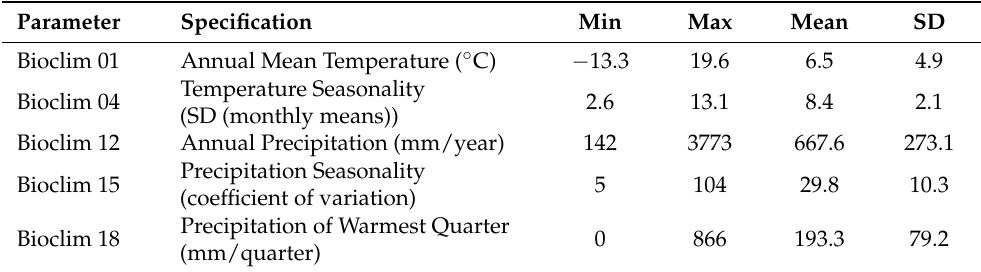
Table 2. Specification and descriptive statistics of the current (1979–2013) climatic parameters used in the multiclass CaPV model. Min = minimum value, Max = maximum value, Mean = weighted arithmetic mean and SD = standard deviation.